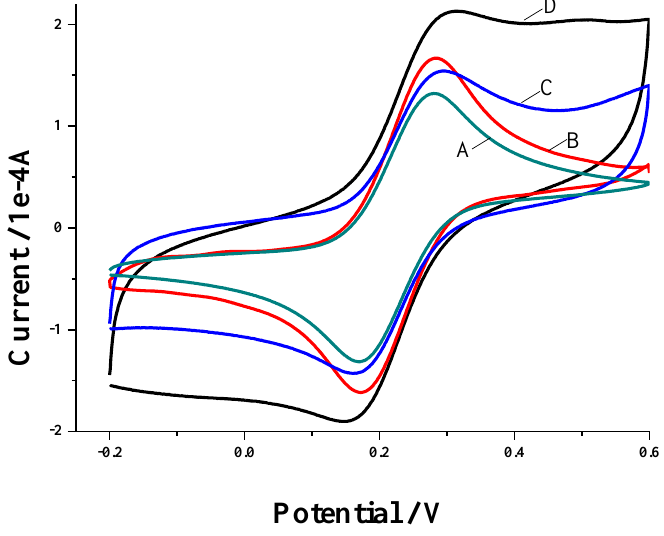
Figure 4. Cyclic voltammograms of 5 mM K poly(4-ABA)/GCE (C) and poly(4-ABA)/MWNTs/GCE (D). Scan rate: 100 mV s −1